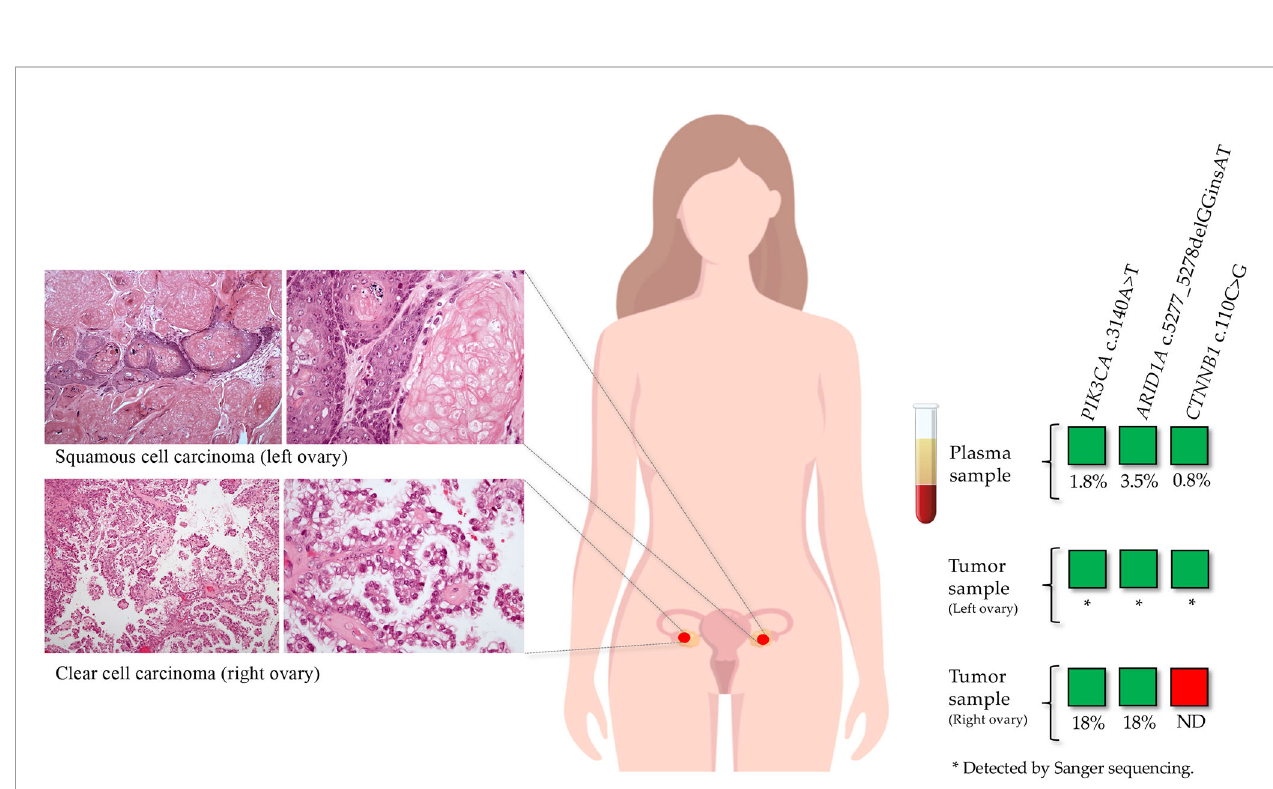
FIGURE 4 | Inter-tumor heterogeneity detected by ctDNA analysis in a patient diagnosed with synchronous tumors on both ovaries. In a tumor sample from the right ovary, a PIK3CA and an ARID1A pathogenic variants were identi fi ed. This tumor consisted of a clear cell carcinoma with a papillary growth pattern. In the matched plasma sample, in addition to these two variants, a CTNNB1 pathogenic variant was detected. We tested a tumor sample from the left ovary by Sanger sequencing, in which the three variants were identi fi ed. The left ovarian tumor consisted of a squamous cell carcinoma with abundant